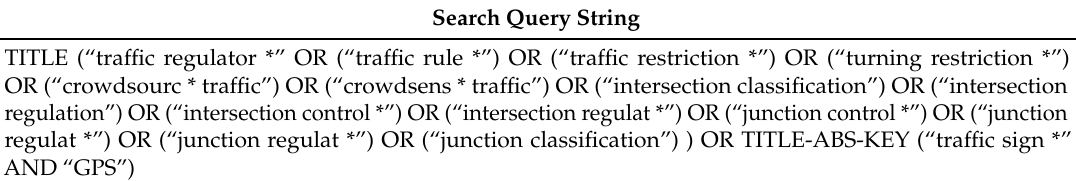
Table 4. The Query string that was used in Scopus search